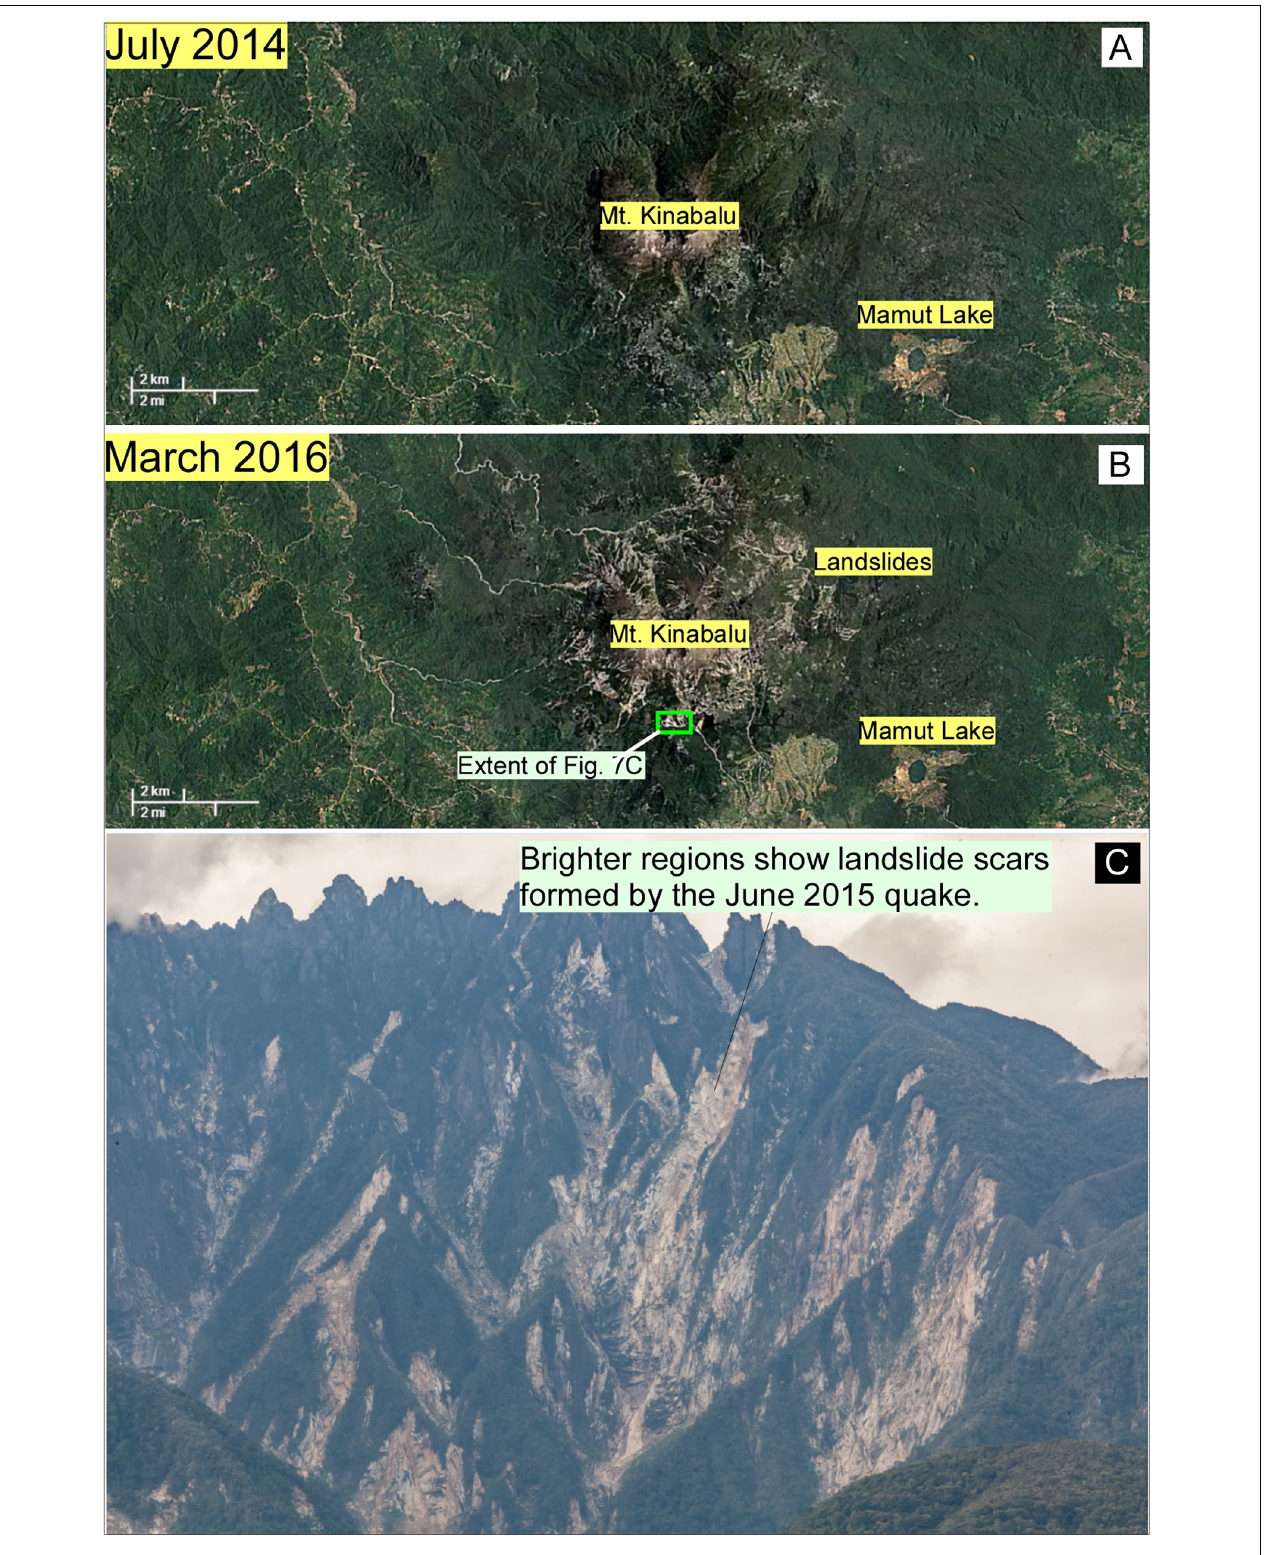
FIGURE 7 | Google satellite images show the Mount Kinabalu region before (A) , and after the June 2015 earthquake (B) . The extent of landslide occurrence on the steep slopes on the mountain is clearly visible. Field evidence of this is shown at the bottom (C) .